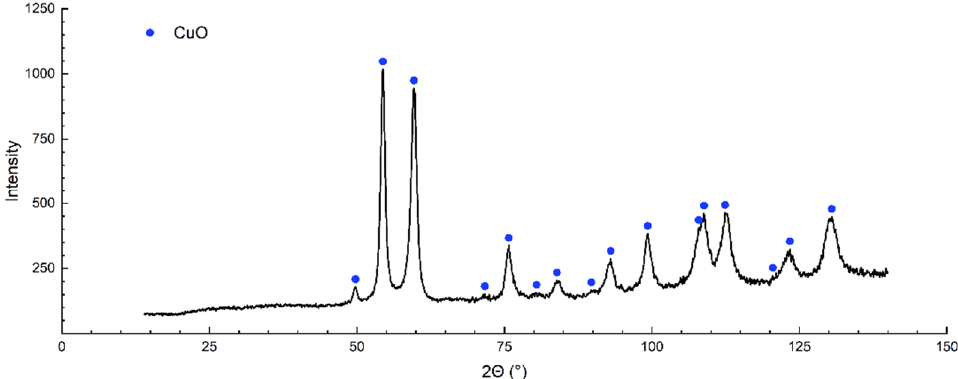
Figure 3. X-ray diffraction pattern of copper (II) oxide microspheres (CuO sph).